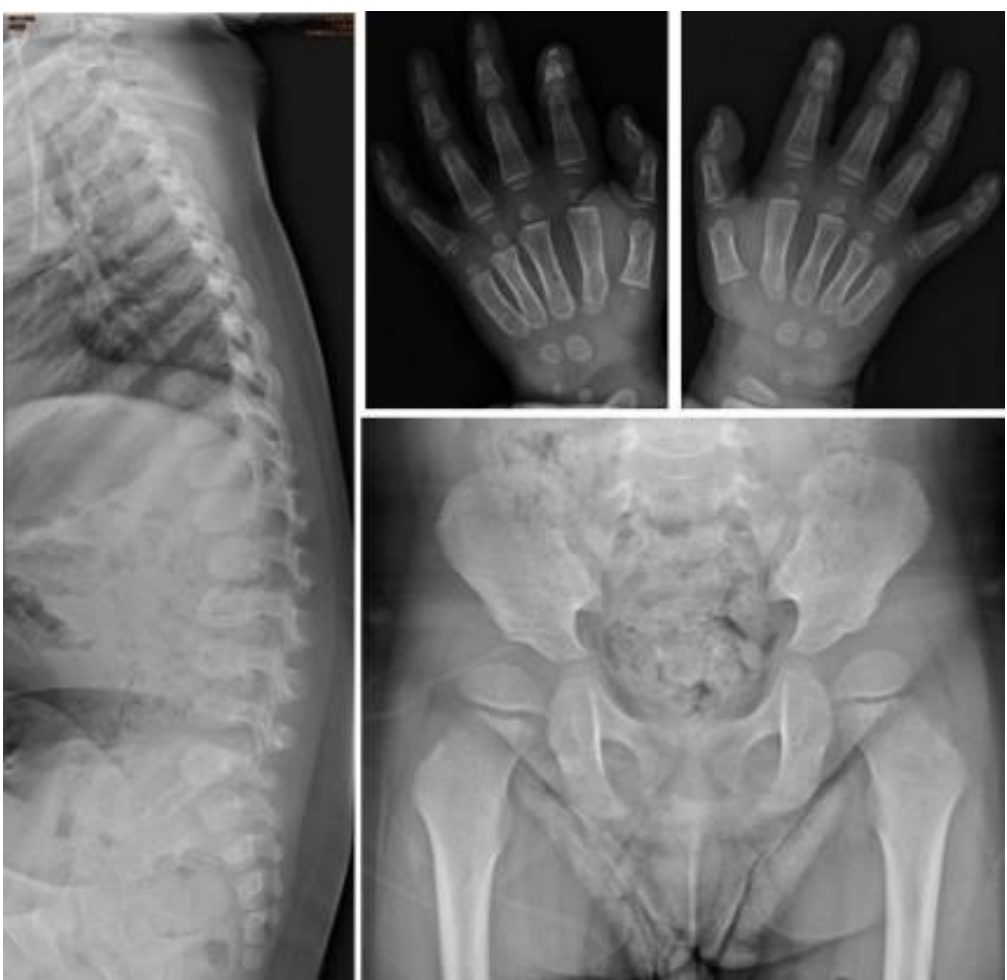
Figure 7. The bone X-rays at 2.8 years of age of patient No. I-6 who had the variation allele c.1007 – 1666_c.1180 + 2113 delinsTT. ERT was started at 0.4 years of age. He received HSCT at 0.9 years old. At 2.8 years of age, anterior beaking of lower thoracic to lumbar vertebrae, proximal pointed metacarpal and bullet-shaped phalanges of both hands, and shallowed bilateral acetabuli and coxa valga of both femurs were found.